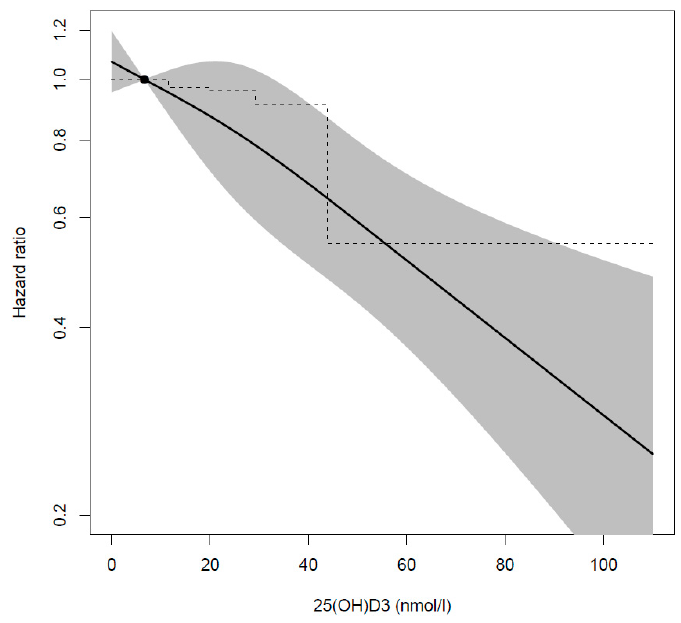
Figure 2. Cubic spline model of the adjusted a hazard ratio b (95% CI) of developing asthma between age 3–9 years and neonatal 25(OH)D 3 concentrations.